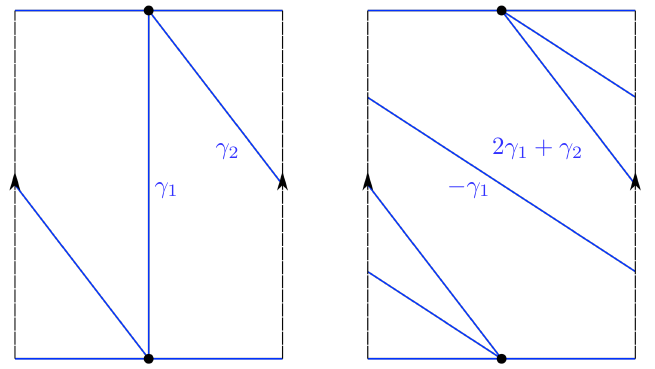
Figure 3 . Triangulation T ϑ for the pure SU(2) gauge theory and its first flip as ϑ is varied. The ultraviolet curve C is a cylinder in this case, and its boundaries provide boundary edges which do not change and do not correspond to any electromagnetic charge γ . We draw it as a plane with opposite sides identified as indicated by the arrows.